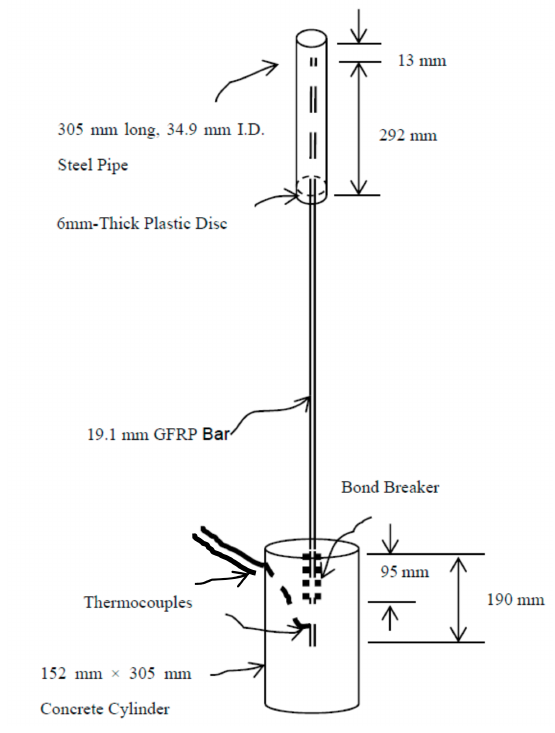
Figure 3. Bond Test